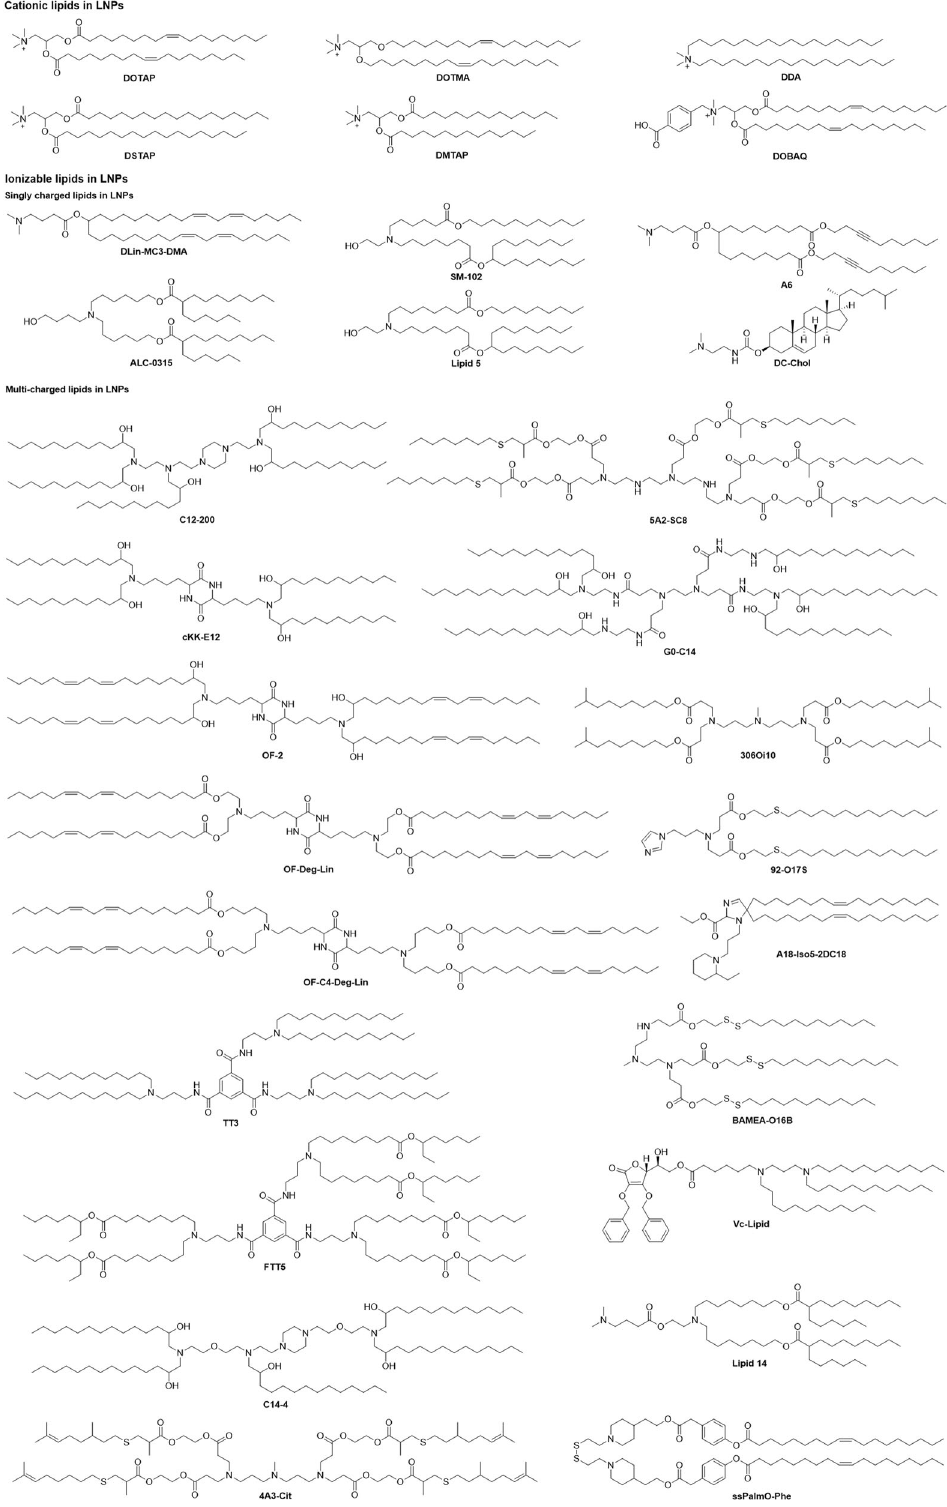
Fig. 6 Positively charged lipids in mRNA-loaded lipid nanoparticles. The most widely used carrier of mRNA preparations is LNPs. Positively charged lipids play a vital role in LNPs because LNPs encapsulate mRNA through electrostatic adsorption between lipids and mRNA. These lipids can be classi fi ed into cationic lipids and ionizable lipids according to the generation of a positive charge. Furthermore, ionizable lipids can be divided into single-charged lipids and multicharged lipids. Here, we listed the representative lipids used in LNPs, including DOTMA, DOTAP, DSTAP, DMTAP, DDA, DOBAQ, DC-Chol, 8,171 DLin-MC3-DMA, 540 SM-102, 67 A6, 163 ALC-0315, 541 and Lipid 5. 151 Multicharged lipids in LNPs include C12-200, 512 5A2-SC8, 166 cKK-E12, 542 G0-C14, 151 OF-2, 157 306Oi10, 154 OF-Deg-Lin, 158 92-O17S, 160 OF-C4-Deg-Lin, 543 A18-Iso5- 2DC18, 165 TT3, 544 BAMEA-O16B, 545 FTT5, 546 Vc-Lipid, 546 C14-4, 161 Lipid 14, 287 4A3-Cit, 547 and ssPalmO-Phe 548